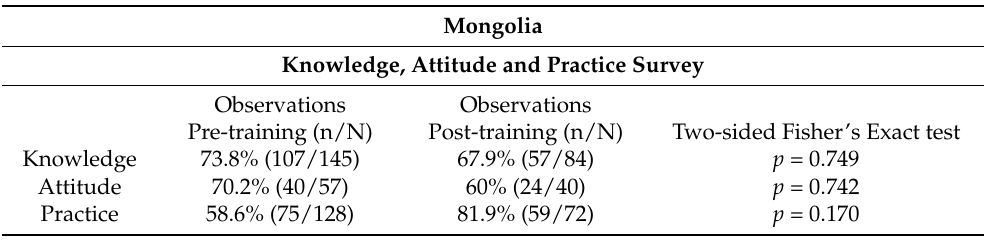
Table 2. Change in Desired Answers of Knowledge, Attitude and Practice Surveys Between Pre- training and Post-training Using a Fisher’s Exact